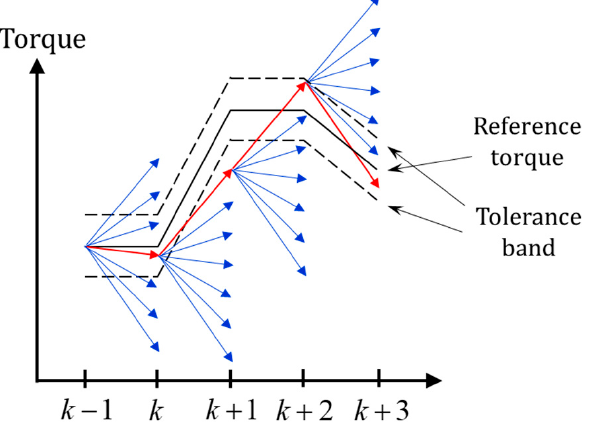
Figure 4. Choice of candidate vectors, blue: torque generated by the candidate voltage vectors, red: torque generated by the chosen vector.